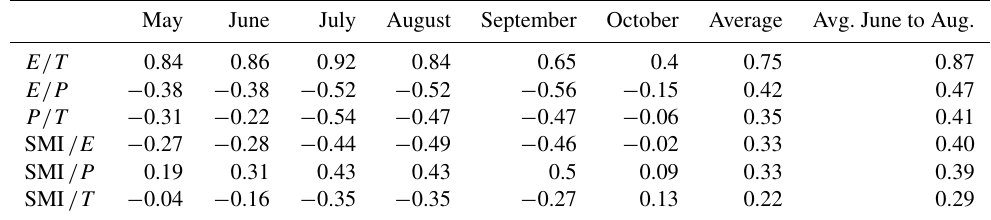
Table 2. Comparison of Pearson correlation coefficients of the exogenous